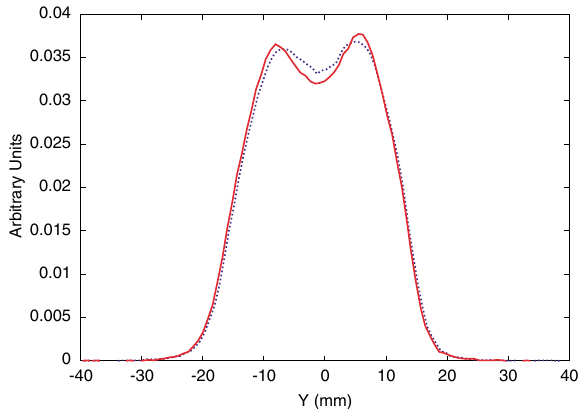
FIG. 14. (Color) Simulated vertical rms beam emittances for the notched and non-notched beams during accumulation of full and half intensity beams. The red solid and orange dashed lines are the notched beams at full and half intensity, respec- tively, and the blue dotted and turquoise dashed lines are the non-notched beams at full and half intensity, respectively.